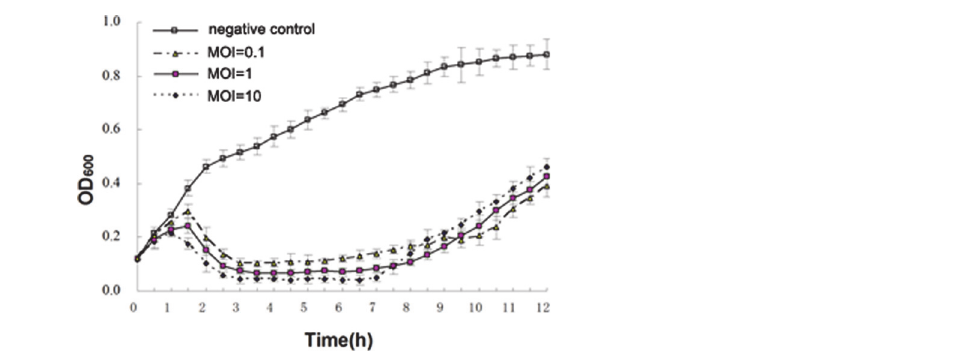
Figure 3. Antibacterial curve of phage PPA-ABTNL at different multiplication of infection in vitro . PA5- 1-1 strain was lysed by the phage PPA-ABTNL in LB medium at 37°C. OD600 development of uninfected control culture and parallel cultures infected with phage at different multiplicities of infection (MOI) was measured. n = 3.